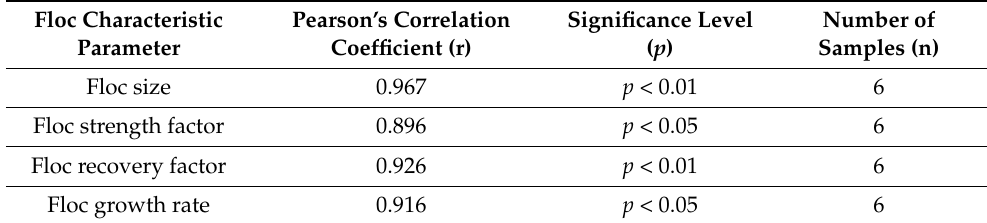
Table 2. Correlation analysis between algal removal efficiency and floc size, floc strength, floc re- covery factor, and floc growth rate.